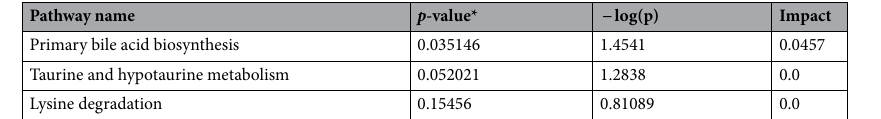
Table 6. List of biochemical pathways (MetaboAnalyst) identified in ETRF against TRF. * p -value of less than 0.05 is regard as significant ( p <